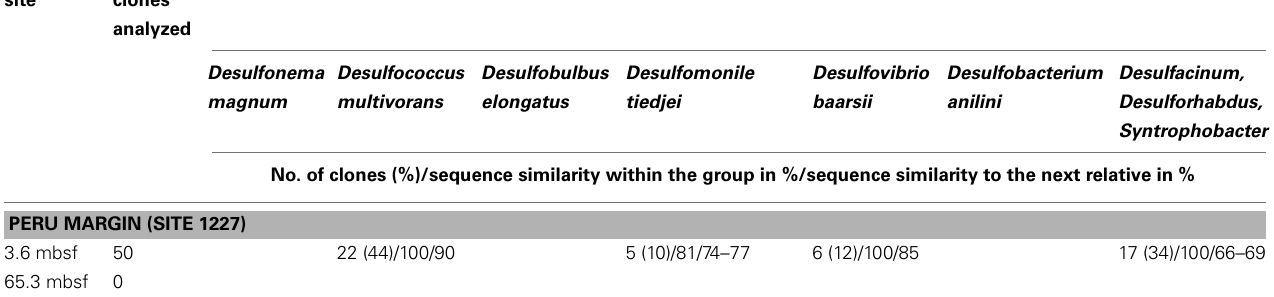
Table 1 | Gene aprA clone library data for three sediment samples of the Peru margin and the Black Sea each.